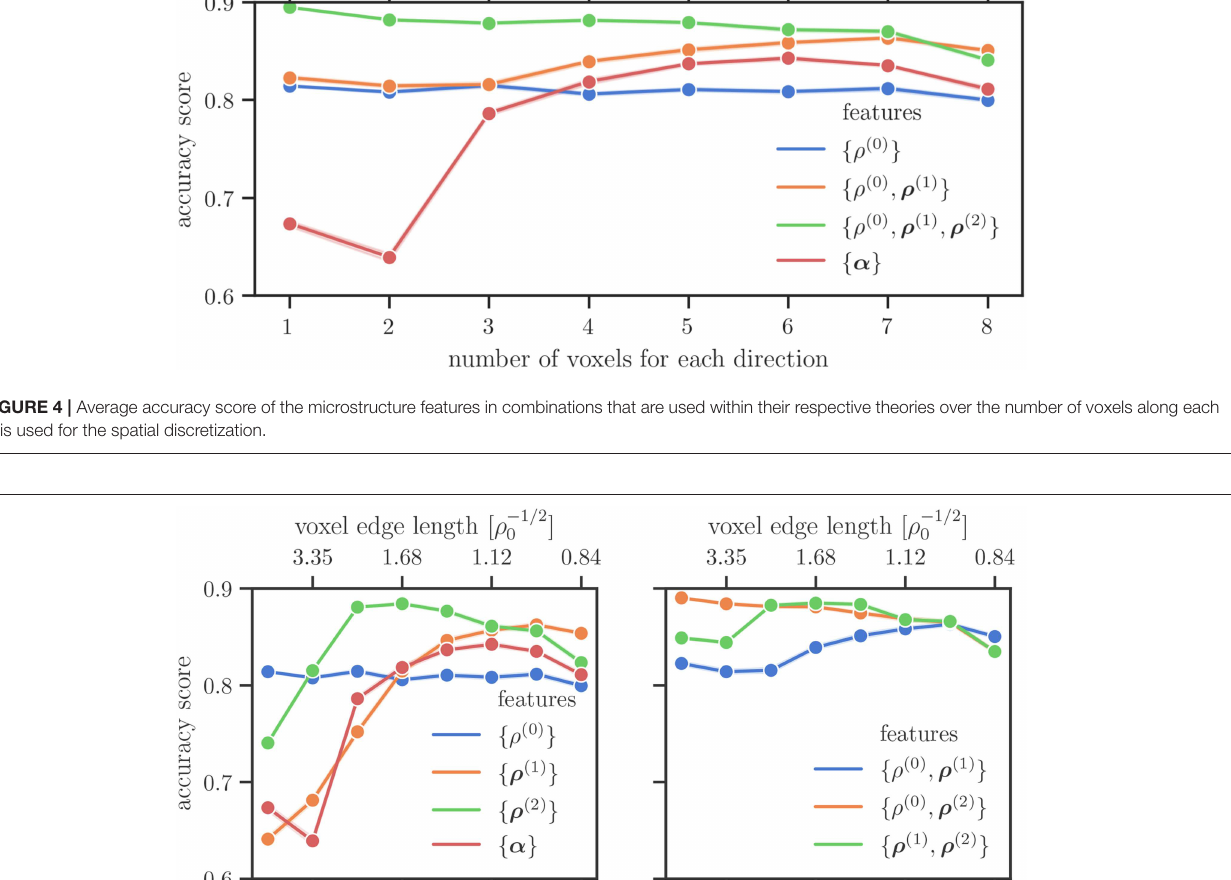
FIGURE 5 | Average accuracy score on the test data set for different features and their combinations. In the right plot the lines for for a larger number of voxels for each direction.